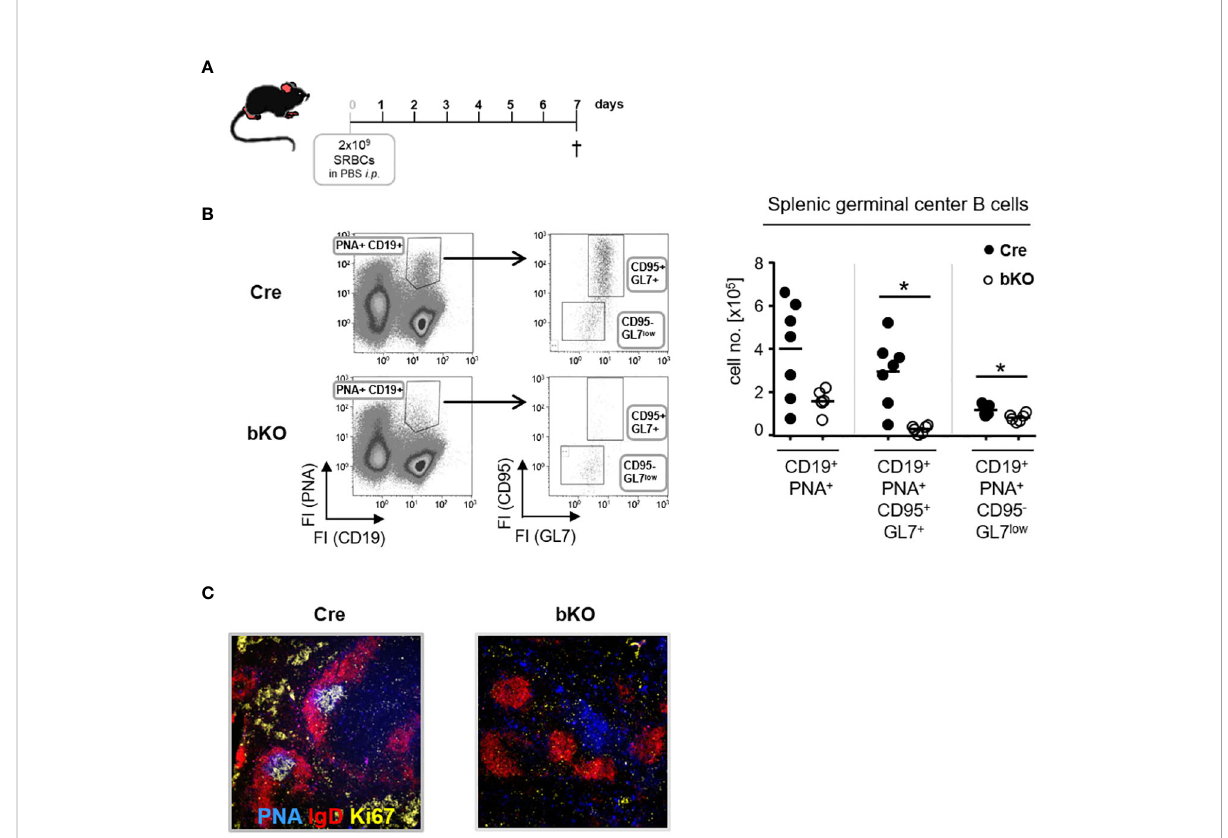
FIGURE 2 DGCR8 is essential for germinal center formation. (A) DGCR8-bKO mice and Cre control animals were immunized with sheep red blood cells (SRBC) and analyzed one week later. (B) Flow cytometric analysis of splenic cells from DGCR8-bKO mice and Cre control animals treated in (A) . GC B cells were de fi ned as CD19 + PNA + and further subdivided into CD95 + GL7 + and CD95 - GL7 low cells. Cell numbers were calculated for the whole spleen. n=6-7 mice per genotype. (C) Immuno fl uorescence microscopy of splenic cryosections from mice treated in (A) . Sections were stained for IgD (red), PNA (blue), and Ki67 (yellow) to visualize the FO mantle zone (IgD + ), as well as the light- and dark zone of the GC (PNA + or Ki67 + ). Each dot represents a mouse and bars indicate the mean of all mice with the same genotype. The Mann-Whitney test was used for statistical analysis.